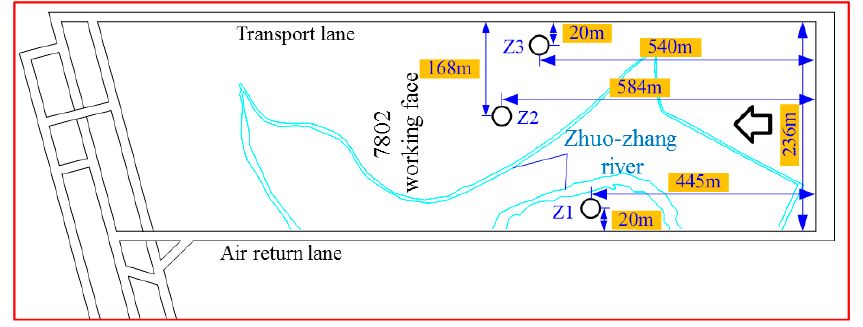
Figure 8. Location map of monitoring holes .